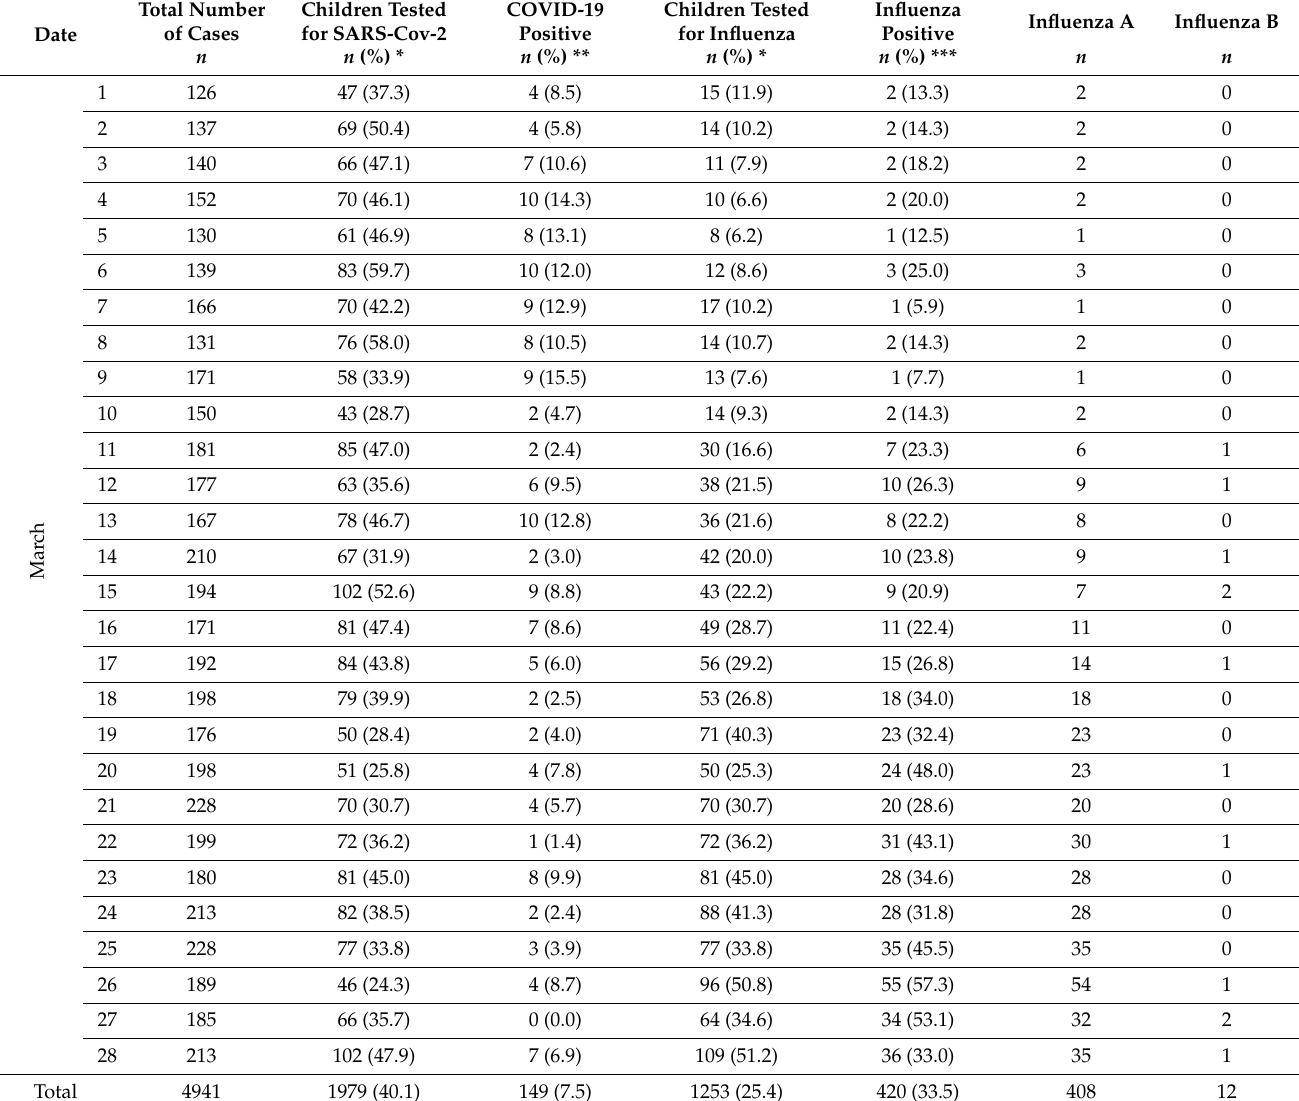
Table 1. Daily number of cases evaluated in the Emergency Department and tested for influenza and